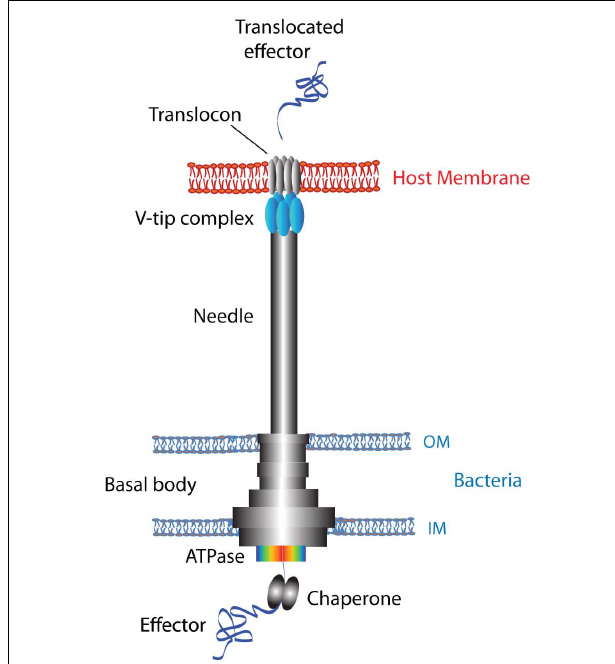
FIGURE 1 | Schematic diagram of the type III apparatus and host membrane. TheT3SS injectisome comprises an extracellular needle structure from the basal body that spans the bacterial inner and outer membranes (indicated as IM and OM), the tip complex topped at the distal end of the needle (shown in blue) and aT3S-associated ATPase located at the cytosolic face of the basal body (shown in a rainbow color).The ATPase is involved in the dissociation of unfolded substrates from the specialized chaperones in addition to supplying energy for protein export (Galan and Wolf-Watz, 2006). It is postulated that the structure and assembly of tip complexes are distinct for each protein family:V-tip proteins form a homo-pentamer complex, IpaD requires IpaB to assemble the hetero-pentamer complex, and EC family proteins assemble into a filamentous structure (Knutton et al., 1998;Veenendaal et al., 2007).The tip complex is required for the assembly of a translocon (PopB and PopD for Pseudomonas ,YopB andYopD for Yersinia ) in the host cell membrane (Cornelis, 2006; Hauser, 2009). An unfolded effector protein is transferred through the channel of the needle and translocon and eventually delivered into the host cytosolic compartment (blue ribbon).